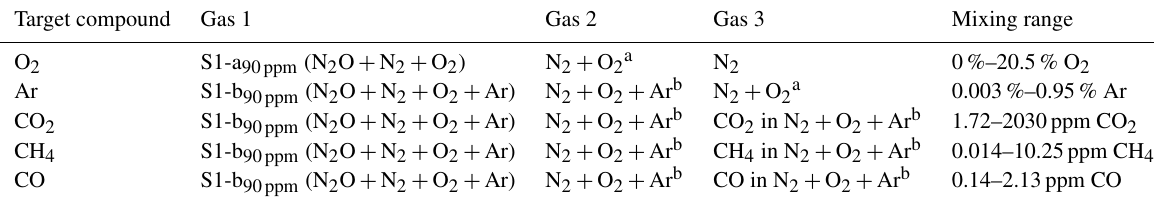
Table 5. Gas mixtures used to test effects of gas matrix (O 2 , Ar) or trace gases (CO 2 , CH 4 and CO) on [ N 2 O ] and isotope deltas. Gas 1 was dynamically diluted with Gas 2 to make up an Anchor gas with [ N 2 O ] of ∼ 330ppb which was systematically measured throughout the experiments to (1) enable drift correction and (2) quantify deviations of the measured [ N 2 O ] and δ values caused by the removal of matrix gases (O 2 and Ar in Sect. 2.4.5) or addition of trace gases (CO 2 , CH 4 and CO in Sect. 2.4.6). Gases 1, 2 and 3 were combined in different fractions to make up sample gas with identical [ N 2 O ] but varying mixing ratio of the target compound. Target compound Gas 1 Gas 2 Gas